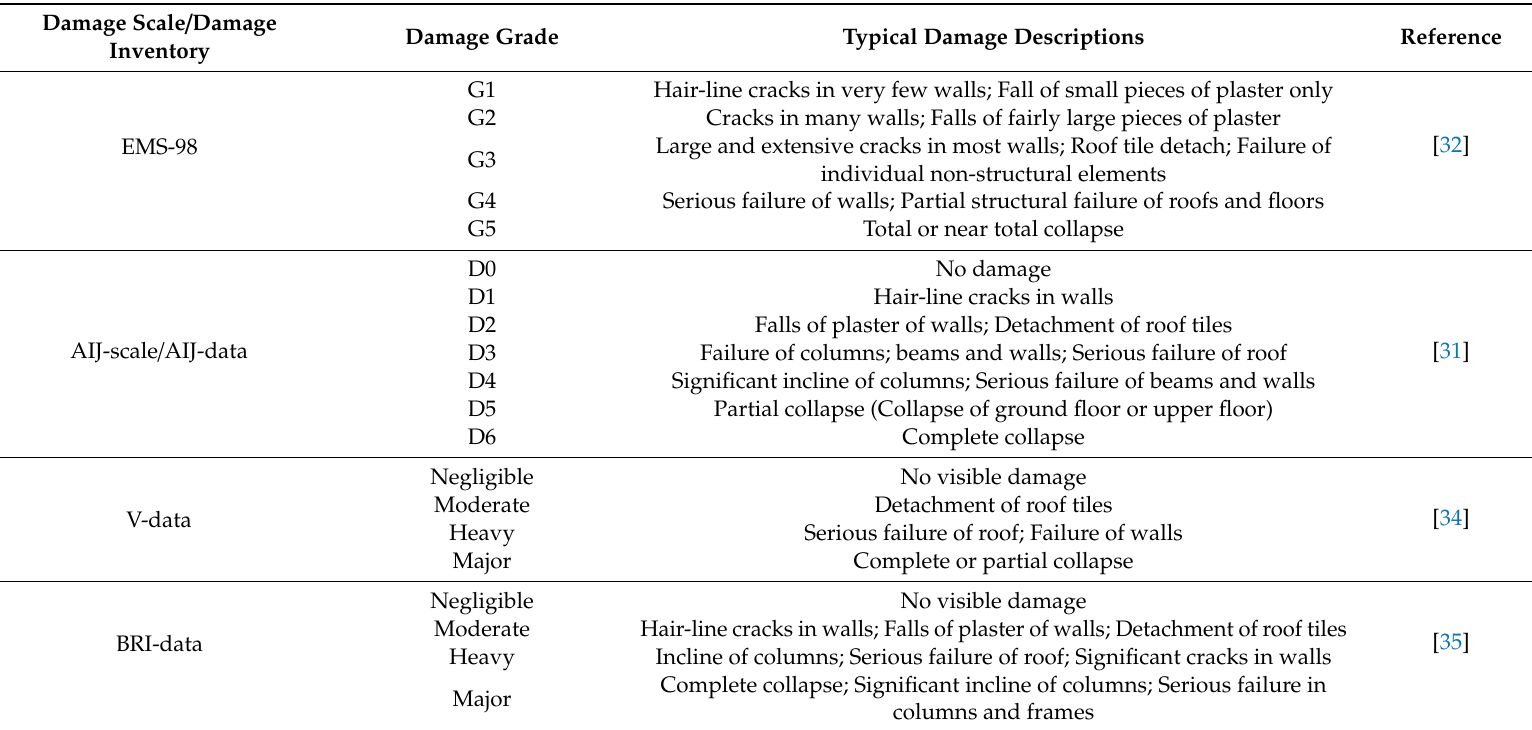
Table 1. Descriptions of the building damage in EMS-98, AIJ-scale, V-data and BRI-data defined in the literature